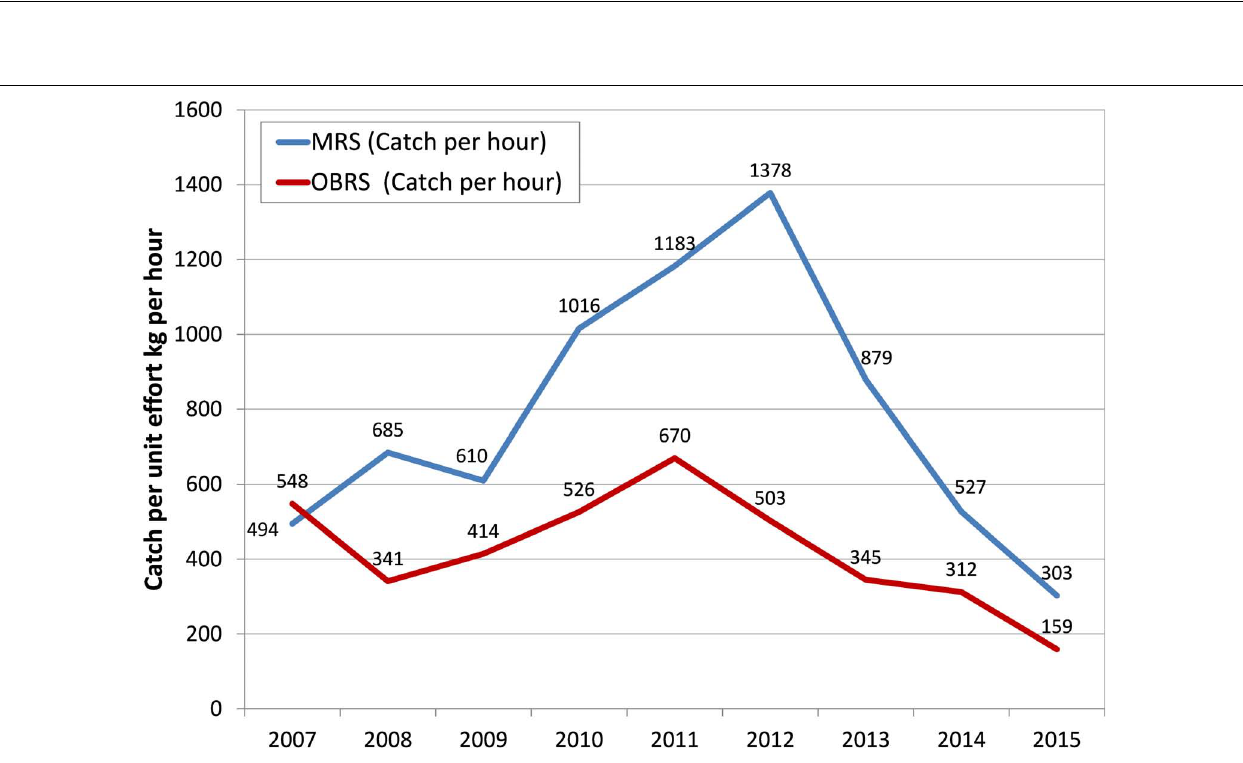
Frontiers in Marine Science |